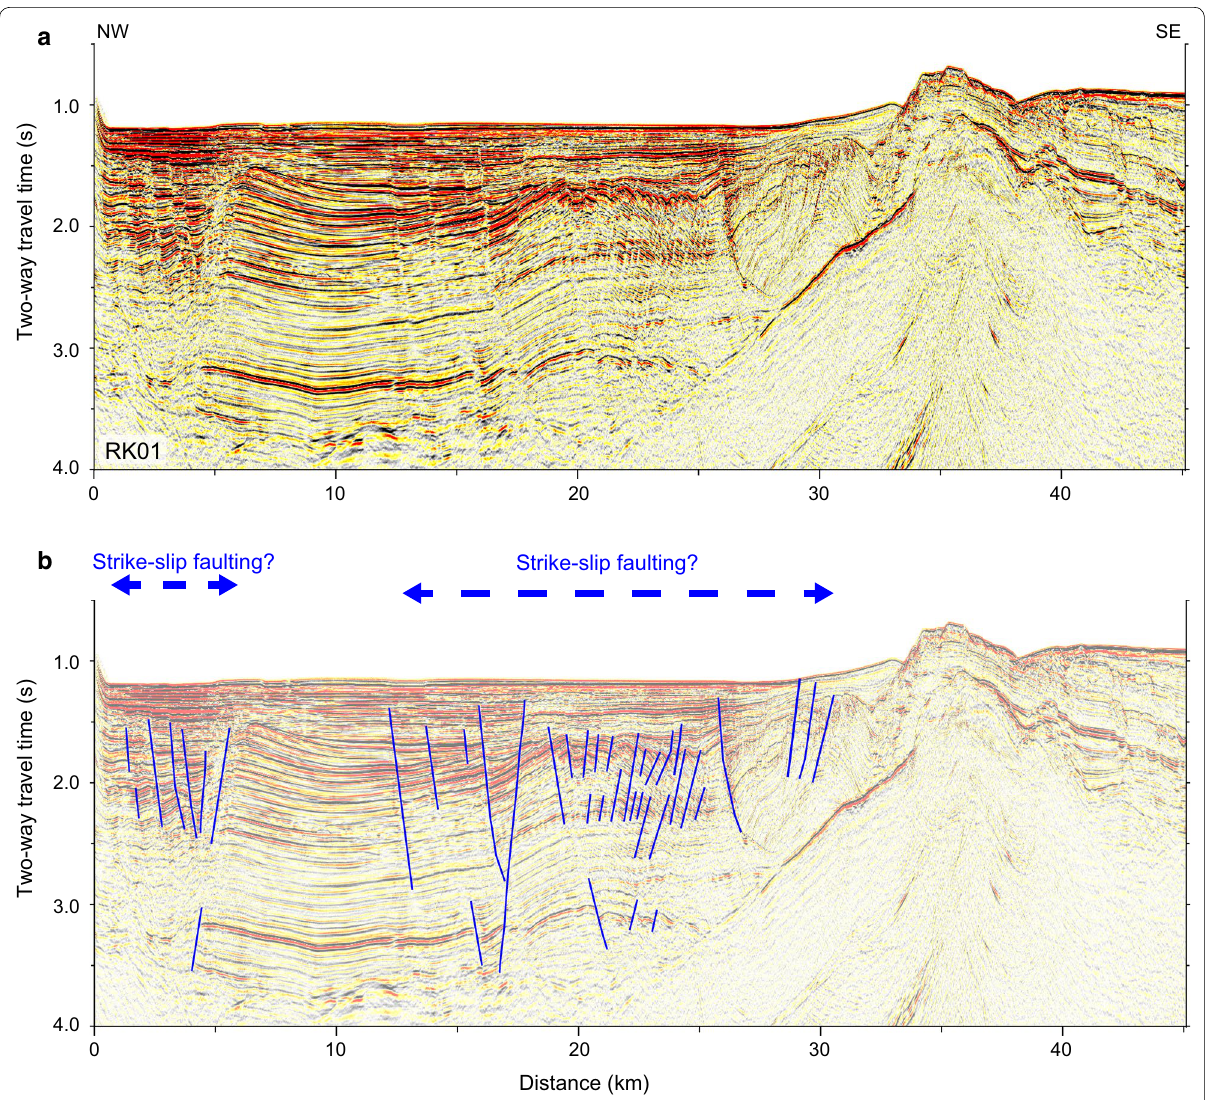
Fig. 7 a Seismic reflection images of the back-arc basin along the RK01 profile and b its interpretation. Blue lines in b indicate interpreted displace- ments. Despite the almost flat seafloor bathymetry of the basin, fault displacements across the sedimentary layers densely occur at many locations. Most of them crosscut each other and thus are interpreted to represent a “flower structure” probably caused by strike-slip